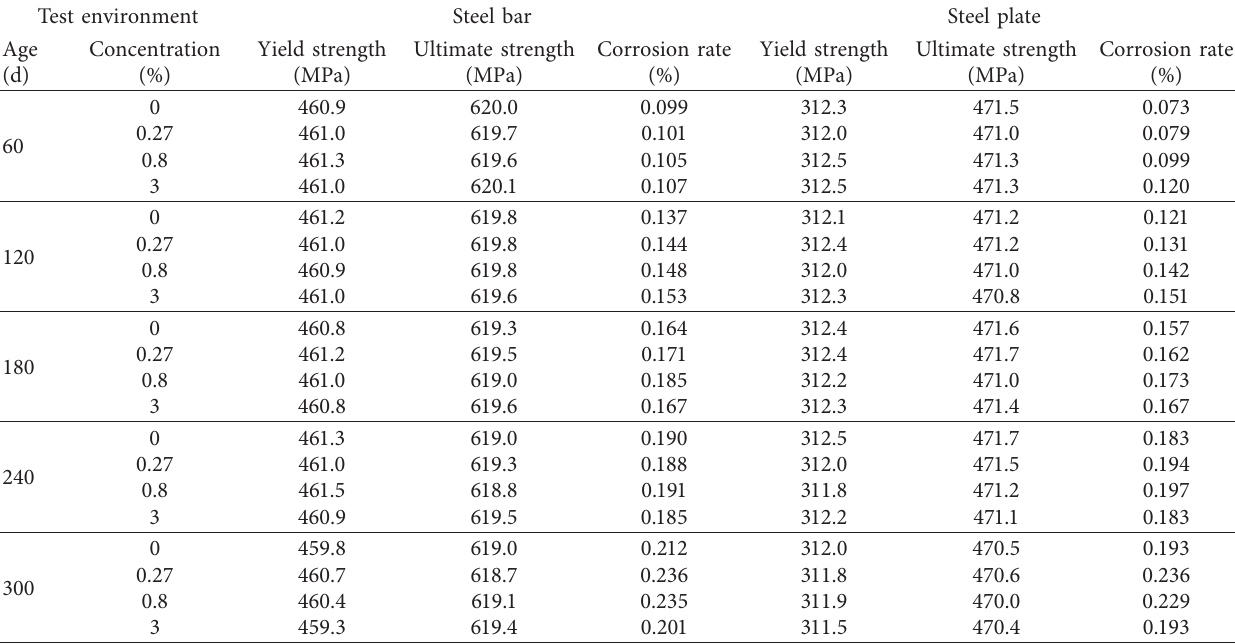
Table 4: Mechanical properties of steel bar and steel plate under dry-wet